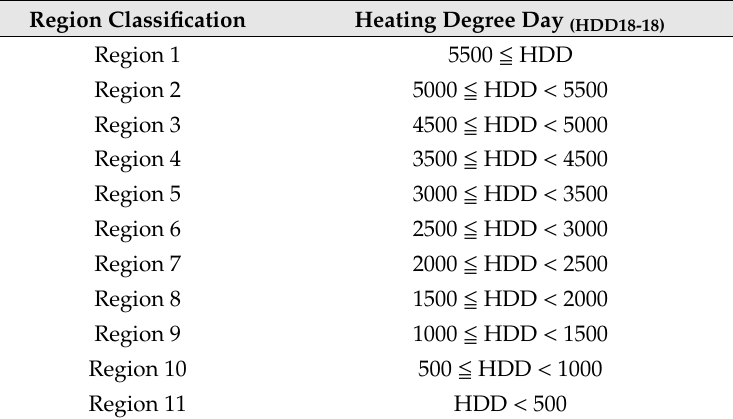
Table 10. Heating degree day (HDD 18-18 ) classification of East